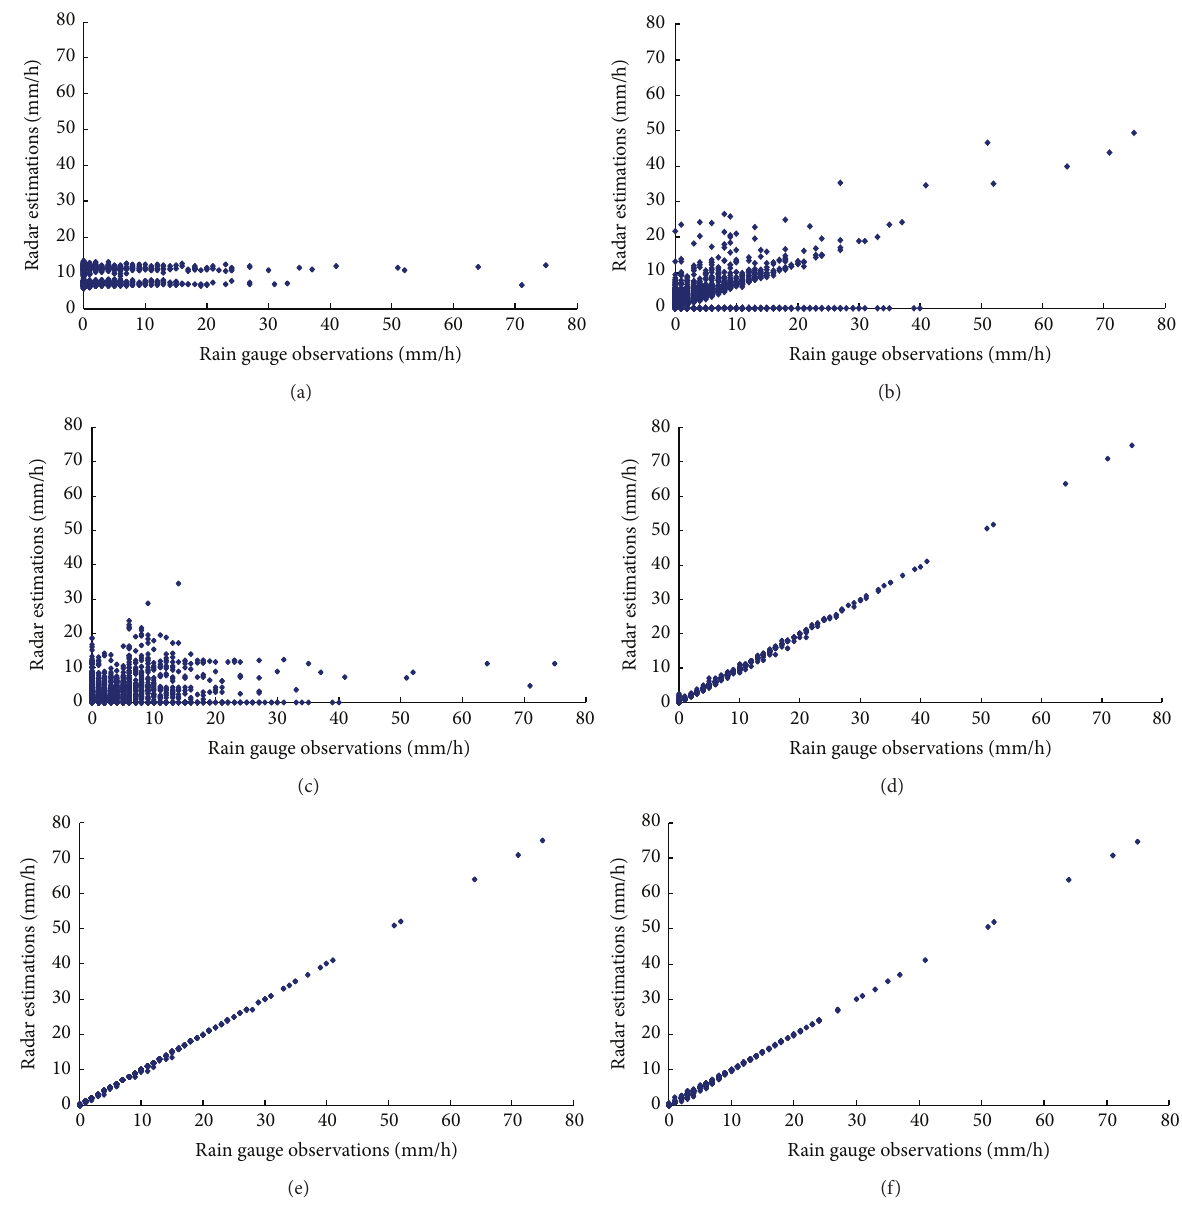
Figure 2: Hourly gauged rainfall observations compared to radar-based estimations: (a) uncalibrated classified Z-R data, (b) Kalman filter, (c) average calibration, (d) optimum interpolation, (e) variational calibration, and (f) statistical weight